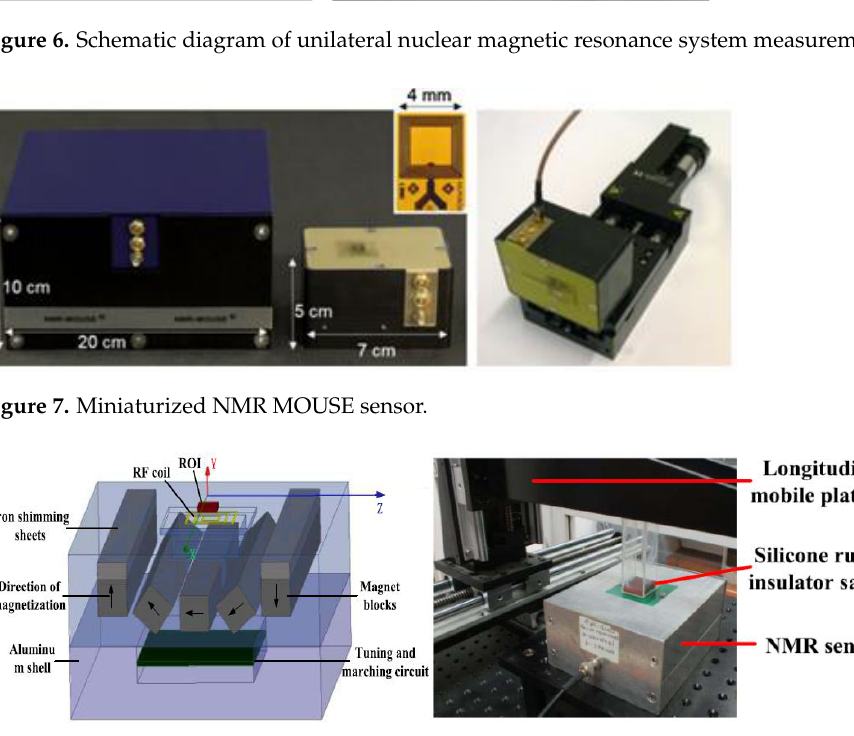
Figure 8. Schematic diagram of portable single-sided magnetic resonance sensing measurement of arc permanent magnet structure.